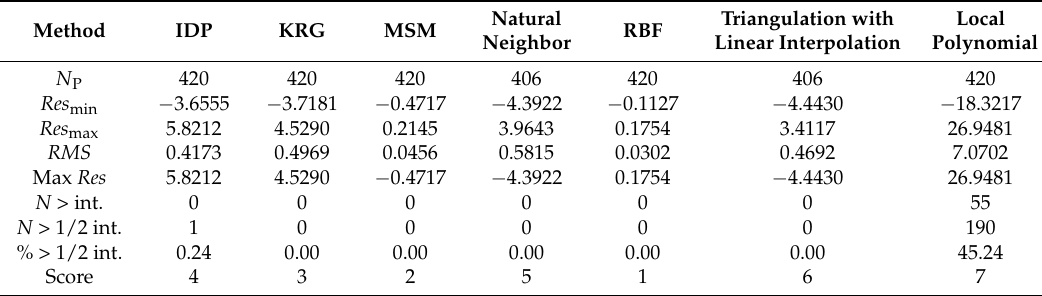
Table 3. Statistical analysis of interpolation methods residuals for gridding ash content in coal samples of thickness layer C.